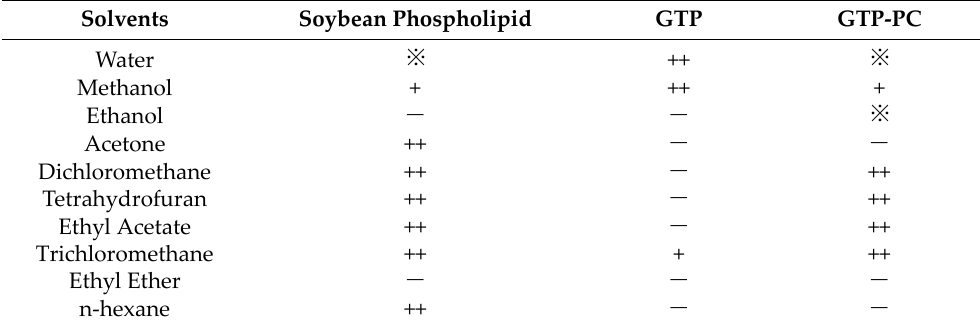
Table 2. Dissolubility of GTP, GTP‑PC, and phospholipids in different solvents (mg/mL). Table 2. Dissolubility of GTP, GTP-PC, and phospholipids in different solvents (mg/mL). Table 2. Dissolubility of GTP, GTP-PC, and phospholipids in different solvents (mg/mL). Table 2. Dissolubility of GTP, GTP-PC, and phospholipids in different solvents (mg/mL).